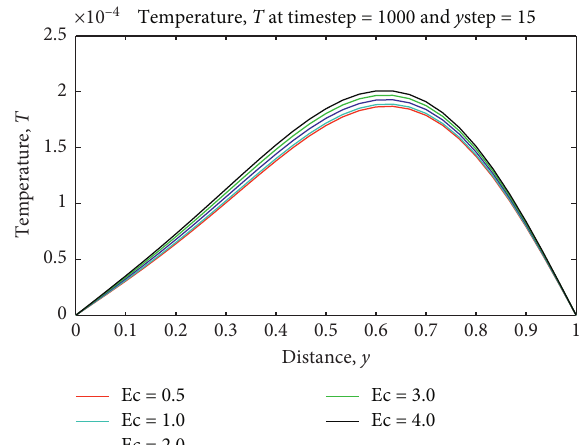
Figure 17: Effects of Eckert number on temperature profile.